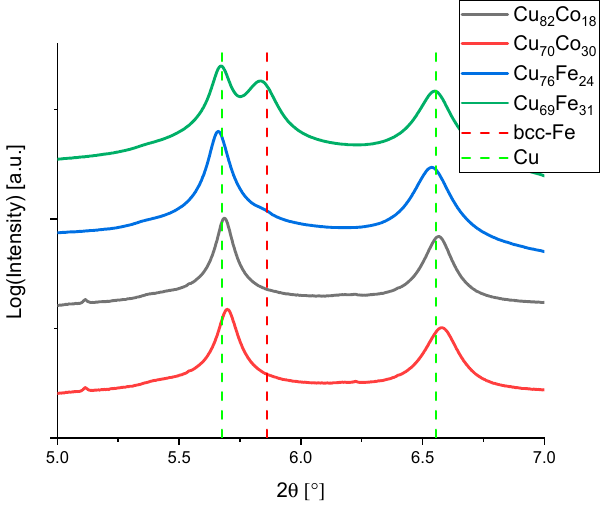
Figure 8. HEXRD pattern of Cu–Co and Cu–Fe samples of low ferromagnetic content, in as-deformed states. In addition, the lines of pure elements are shown, data for bcc-Fe was taken from [35]. GMR was determined for the specimens in the as-deformed and in one annealed state. An